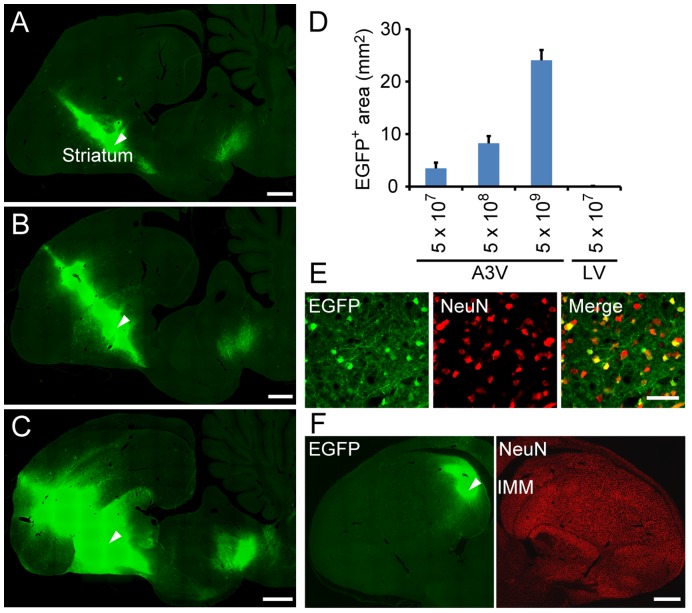
A3V gene transduction in post-hatch chick brain.(A–C) EGFP expression 1 week after A3V injection (a total of 5×107, 5×108, and 5×109 GC, respectively) was analyzed by immunofluorescence labeling of parasagittal sections. Arrowheads indicate injection sites in the striatum. Scale bars are 1 mm. (D) Gene transduction after LV or A3V injection was quantified by measurements of EGFP-expressing area in the parasagittal sections containing injection sites (n = 4). The raw data are listed in Table S4. (E) A3V-treated striatal cells were visualized by double immunofluorescence labeling for EGFP (green) and neuronal marker NeuN (red). Scale bar indicates 50 µm. (F) EGFP expression 24 hrs after A3V injection (a total of 5×109 GC) into the intermediate medial mesopallium (IMM) was analyzed by immunofluorescence labeling of coronal sections. The arrowhead indicates the A3V injection site. Scale bar is 1 mm.